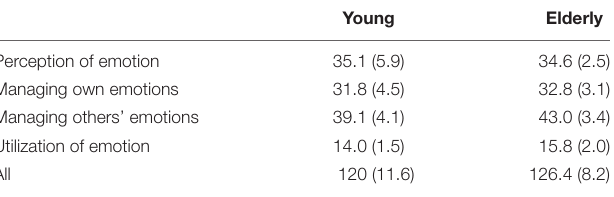
TABLE 4 | The Schutte Self-Report Emotional Intelligence